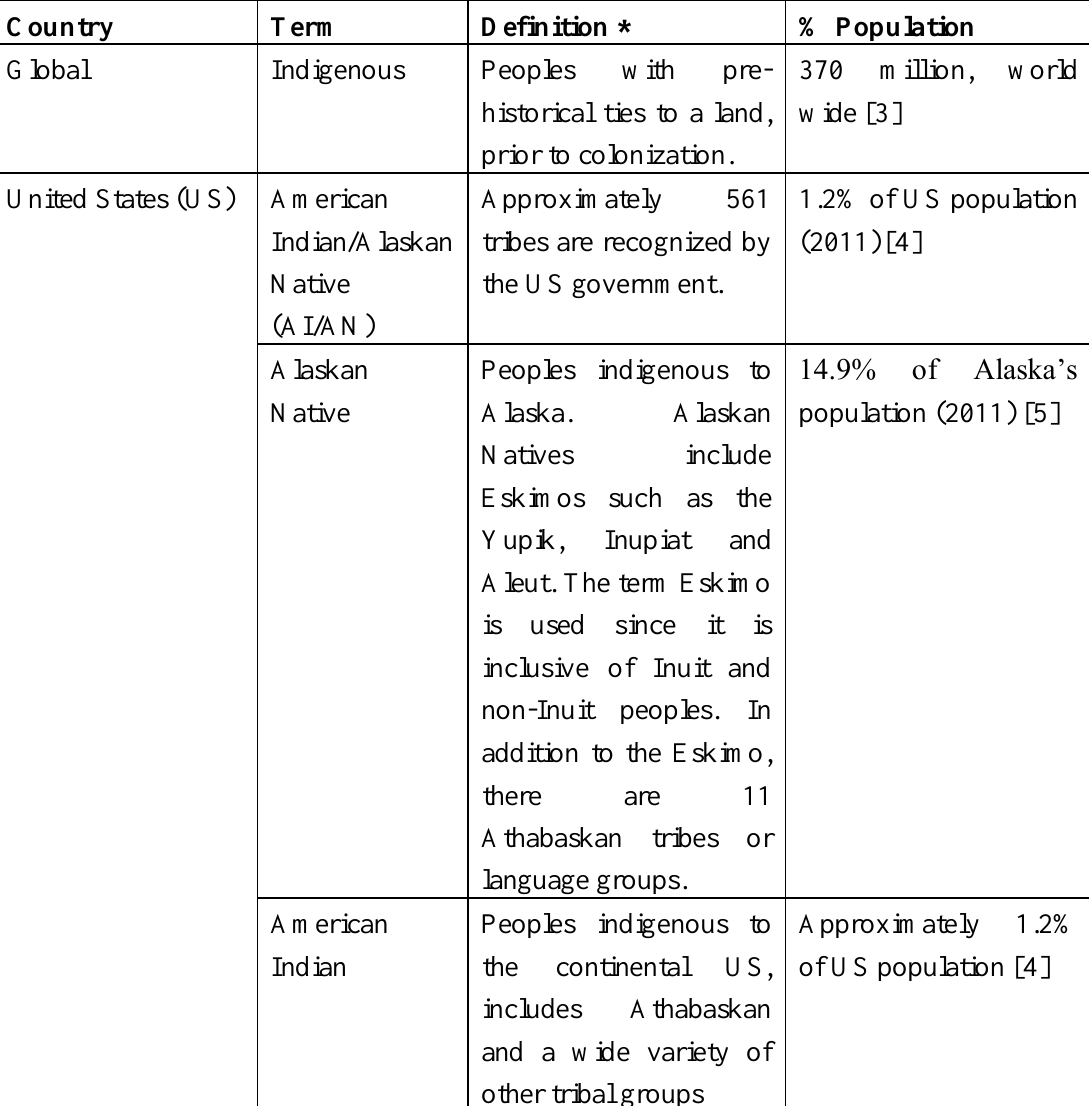
Table 1. American Indian/Alaskan Native and Aboriginal peoples of North